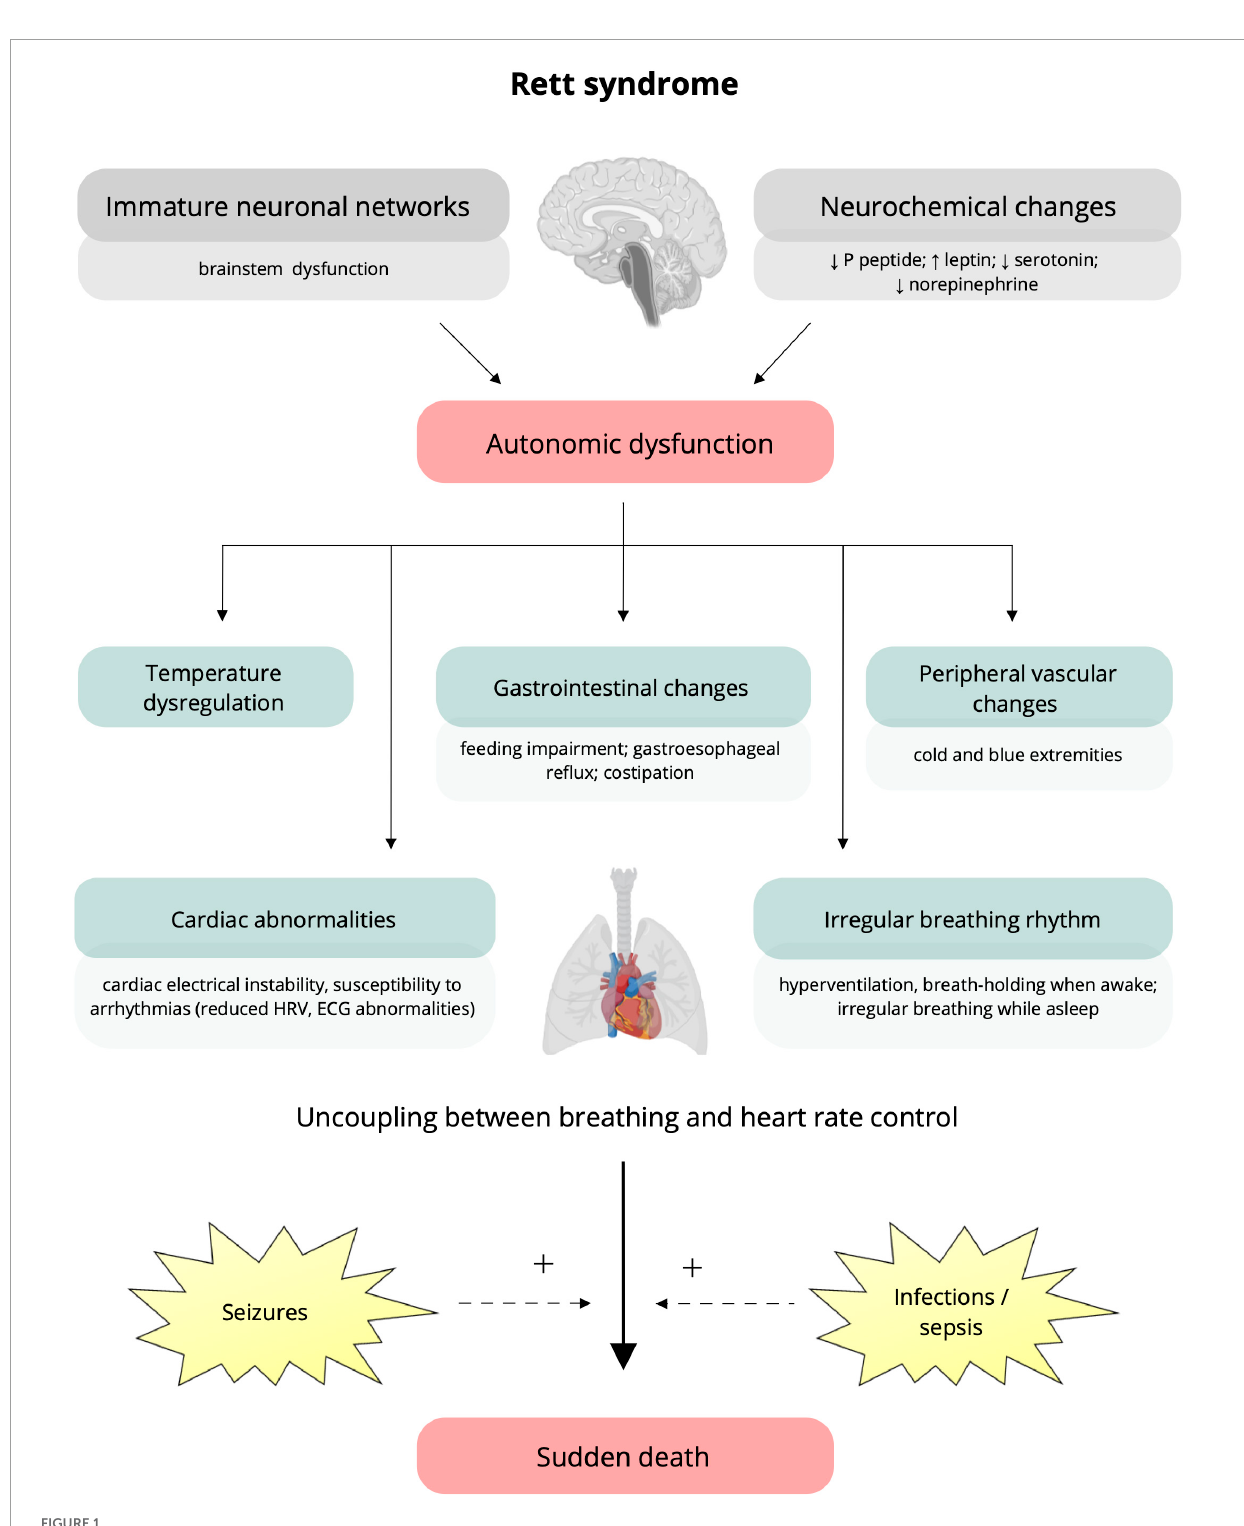
FIGURE1 Putative underlying mechanisms and clinical manifestations of autonomic dysfunction in Rett syndrome. Immature brain networks (specifically brainstem immaturity) and neurochemical alterations (lower levels of P peptide, serotonin, norepinephrine, and increased leptin) (on the top) are assumed to be responsible for the autonomic dysfunction characteristic of Rett syndrome (Singh et al., 2020). Clinical manifestations include temperature dysregulation, alterations in the gastrointestinal system (e.g., feeding impairment, gastroesophageal reflux, and constipation), and peripheral vascular changes resulting in cold and blue extremities (Halbach et al., 2012; Singh et al., 2020). To note, autonomic dysfunction can impact cardiorespiratory function, causing irregular breathing, cardiac electrical instability, and increased susceptibility to arrhythmias, represented by reduced heart rate variability and ECG abnormalities (prolonged QTc, T-wave abnormalities) (Weese-Mayer et al., 2006; Singh and Santosh, 2018; Singh et al., 2020). The occurrence of seizures and infections can increase the underlying autonomic impairment and precipitate cardiorespiratory dysfunction, leading to sudden death (Singh et al., 2020). HRV, heart rate variability; ECG, electrocardiogram; QTc, corrected QT interval; +,